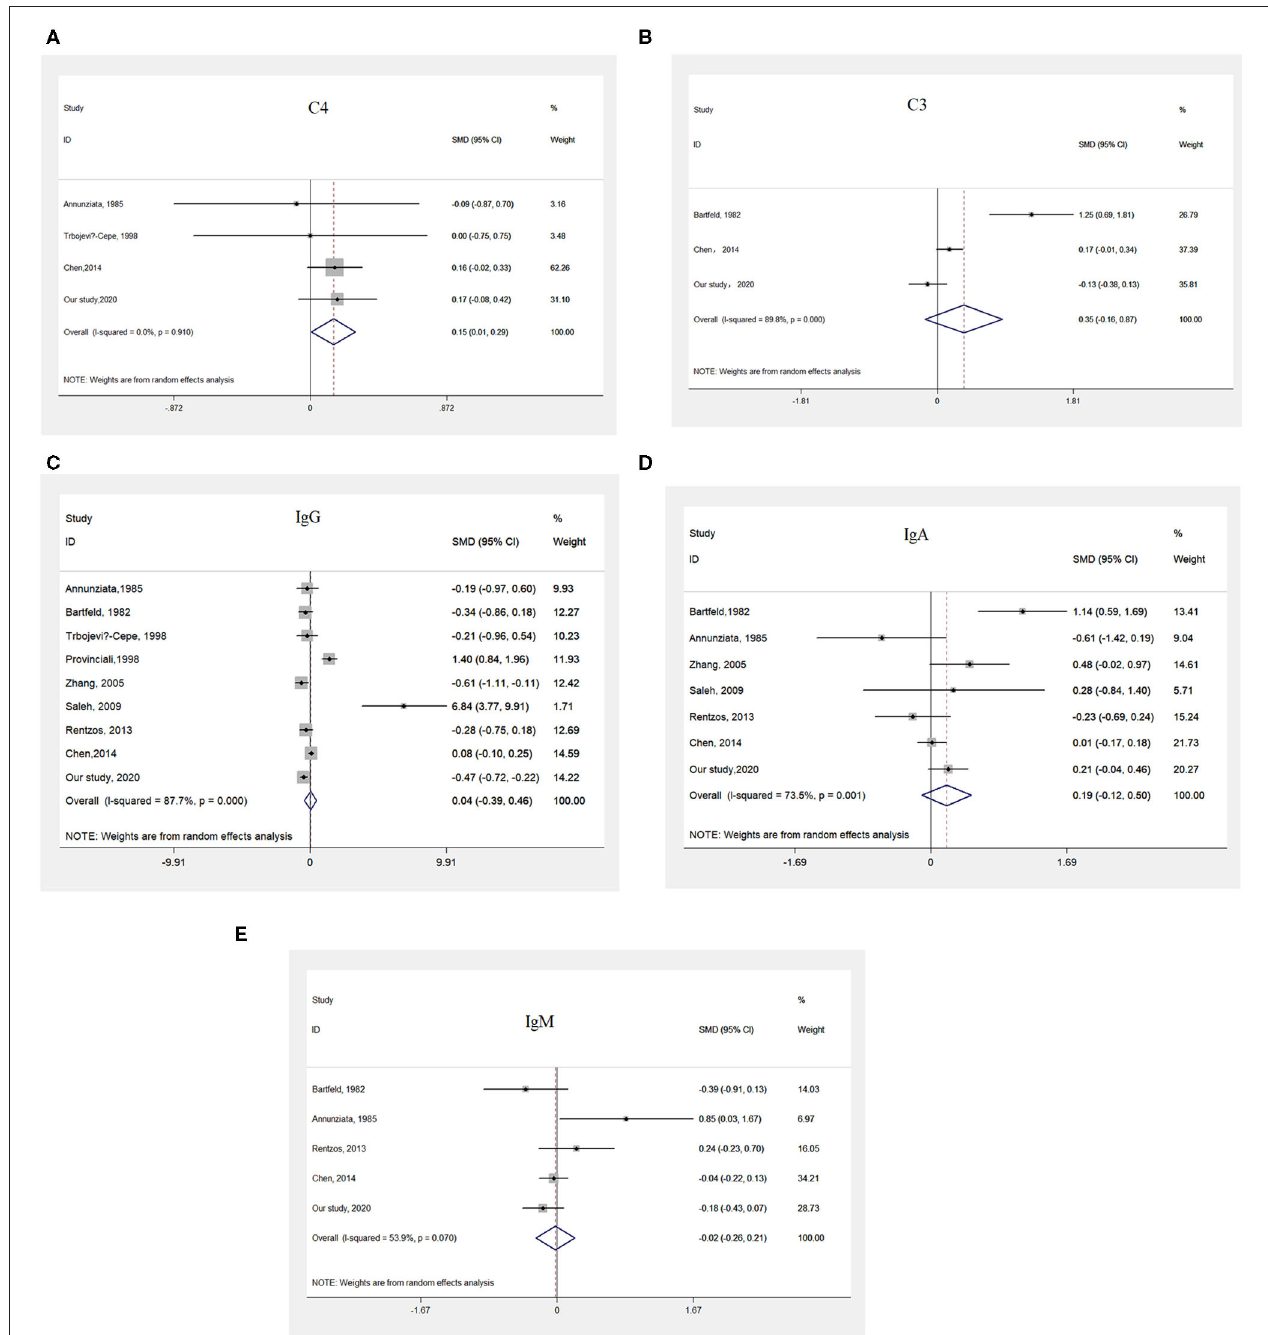
FIGURE 2 | Meta-analysis comparing the serum levels of immunoglobulin and complement between patients with ALS and HCs. (A) Pooled results indicating higher serum levels of C4 in patients with ALS than in HCs. (B) Pooled results suggesting no differences in the serum levels of C3 between patients with ALS and HCs. (C) Pooled results suggesting no difference in the serum levels of IgG between patients with ALS and HCs. (D) Pooled results suggesting no difference in the serum levels of IgA between patients with ALS and HCs. (E) Pooled results suggesting no difference in the serum levels of IgM between patients with ALS and